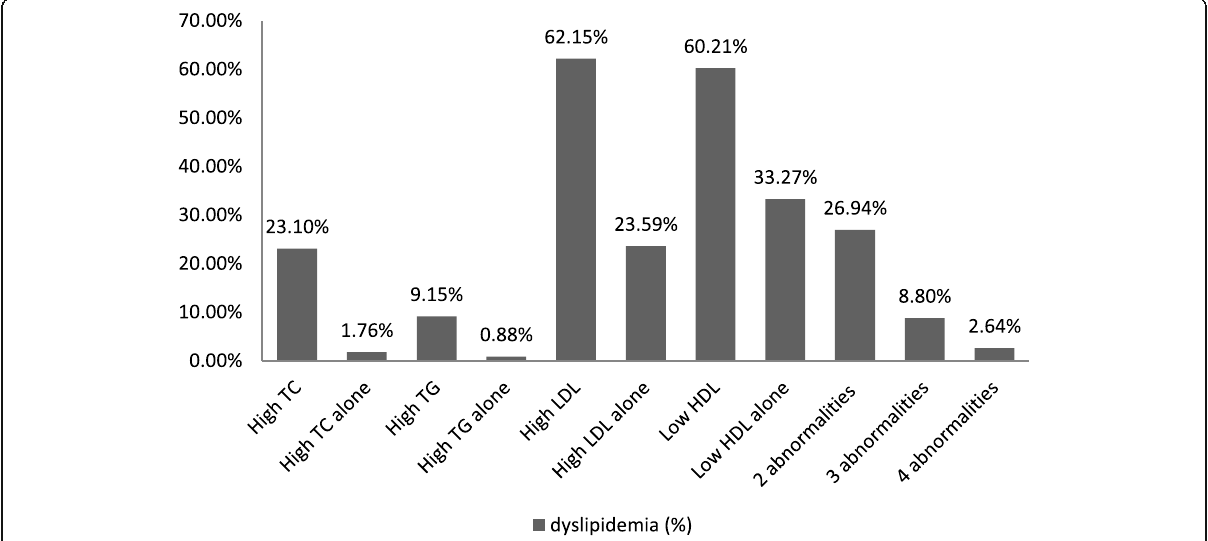
Fig. 1 Pattern of dyslipidemia in the study group. TC, total cholesterol; TG, triglycerides; LDL, low-density lipoprotein; HDL, high-density